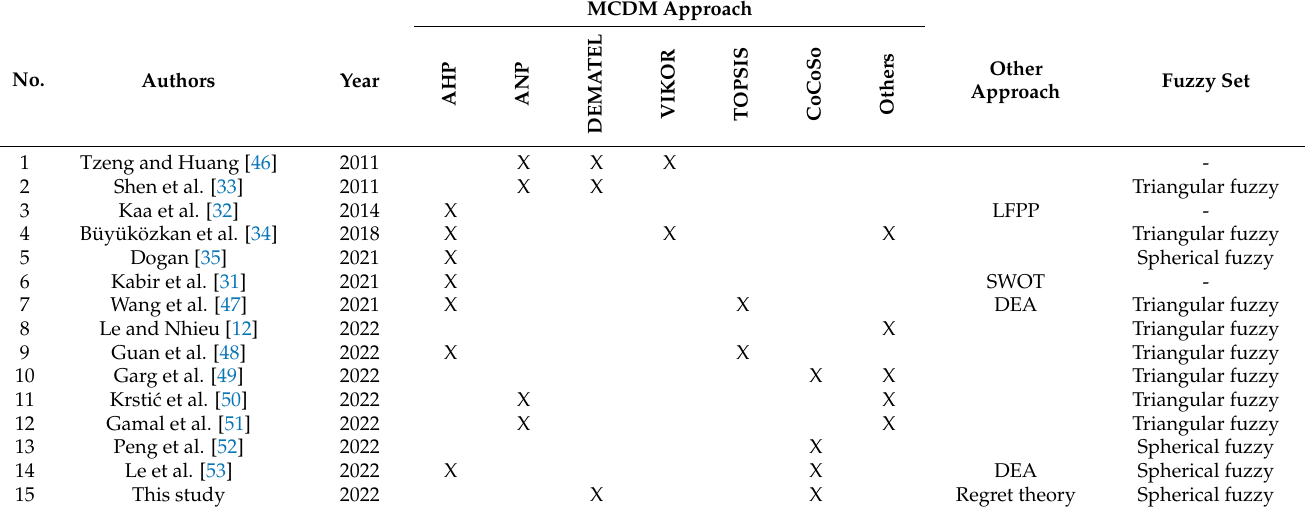
Table 1. Application of MCDM approaches in